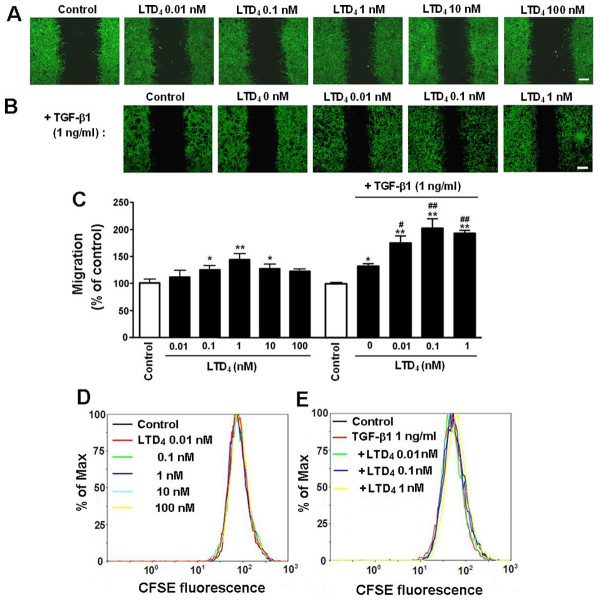
Effect of LTD4on astrocyte migration and TGF-β1-induced migration and proliferation. (A, B), Photomicrographs showing astrocyte migration 24 h after treatment with LTD4 (0.01 to 100 nmol/L) in the absence (A) or presence of TGF-β1 (1 ng/ml, B). Scale bars, 400 μm. (C) Data are reported as mean ± S.E.M.; n = 8; *P <0.05 and **P <0.01 compared with control, #P <0.05 and ##P <0.01 compared with TGF-β1 alone (LTD4 0). (D, E) MFI at 24 h was no significant change 24 h after treatment with LTD4 (0.01 to 100 nM, D) alone or combined with TGF-β1 1 ng/ml (E) (n = 9 for each group, P >0.05).